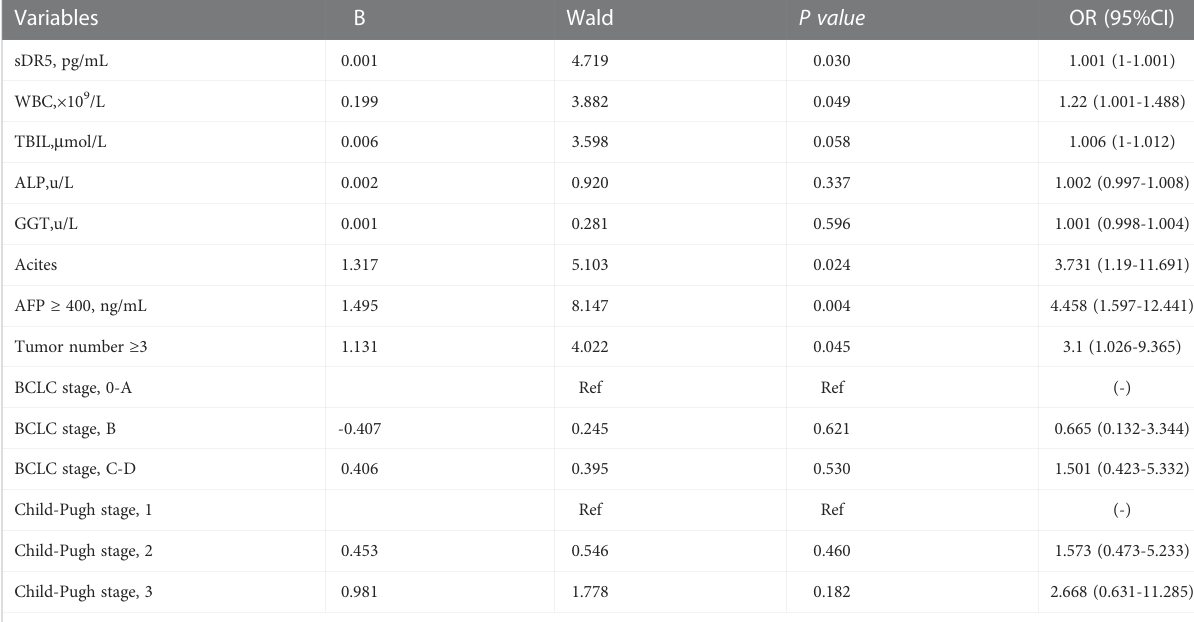
TABLE 3 Multivariate Cox regression analyses for overall survival of patients with HBV-related hepatocellular carcinoma in the derivation cohort.